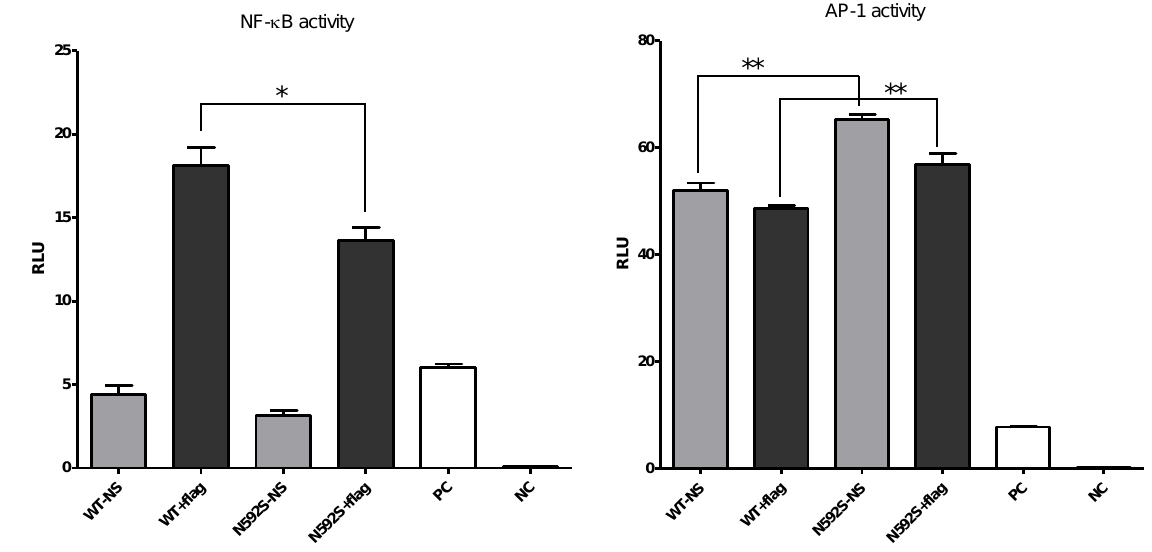
Figure 2. NF- κ B and AP-1 transcription factors activity in WI-38 cell lines transfected with WT and N592S TLR5-variant that are stimulated with flagellin (flag) or unstimulated (NS). Positive control (PC) is a mixture of a constitutively expressing GFP construct, constitutively expressing Firefly lu- ciferase construct, and constitutively expressing Renilla luciferase construct, while negative control (NC) is a mixture of non-inducible firefly luciferase reporter and constitutively expressing Renilla construct. Data shown are representative of three independent experiments. Statistical analysis was performed by using GraphPad, t -test; p -values < 0.05 (*), p -values < 0.01 (**).